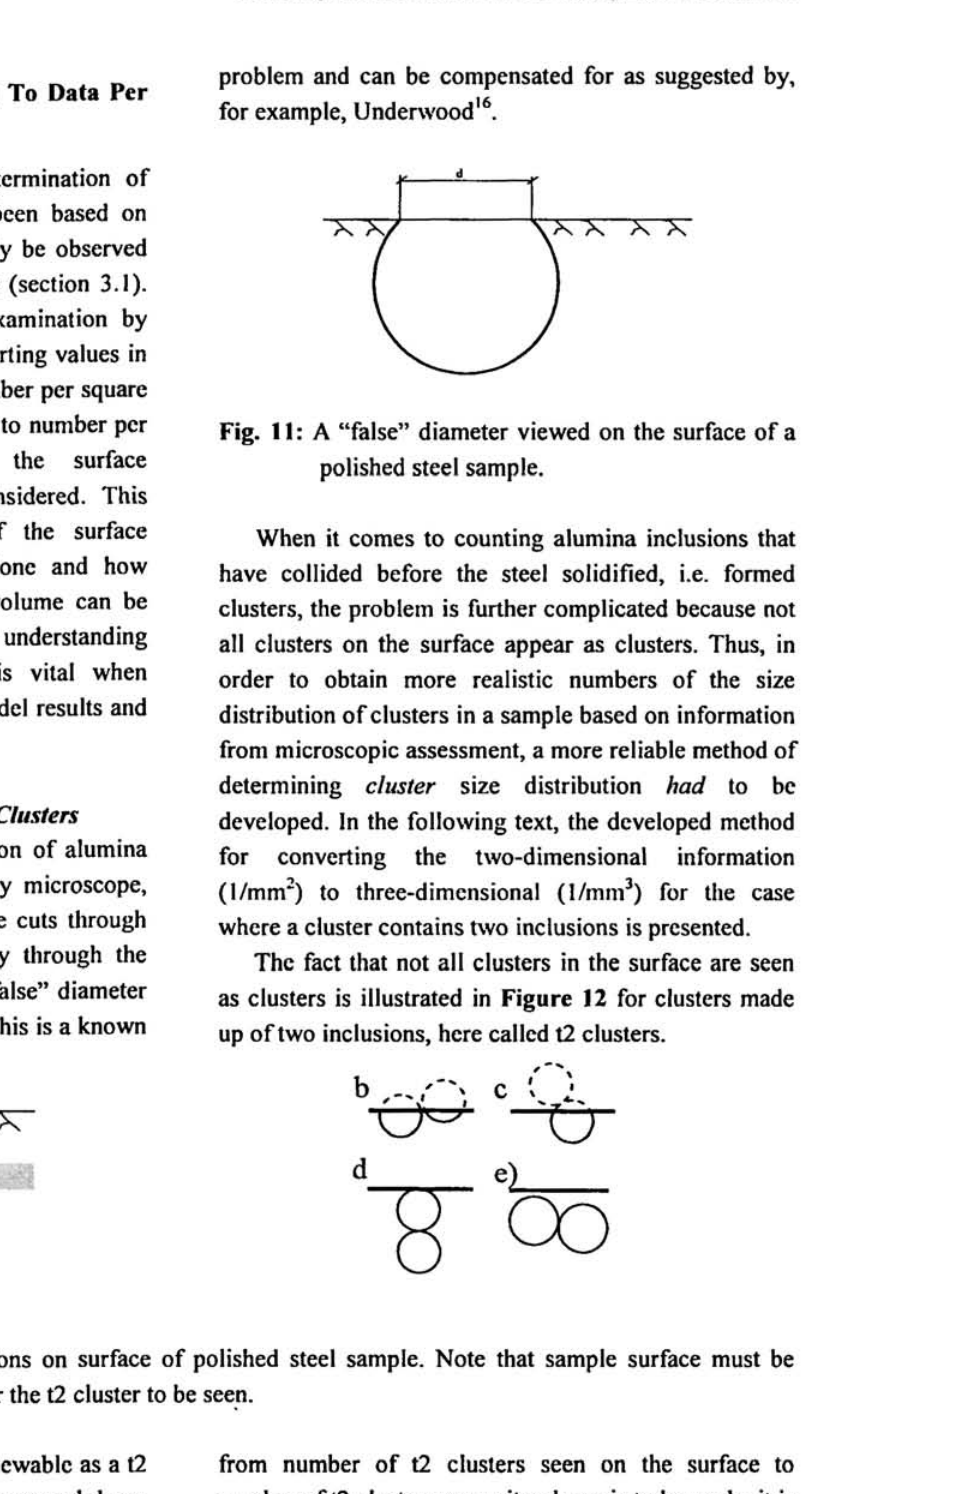
Fig. 11: A "false" diameter viewed on the surface of a polished steel sample.